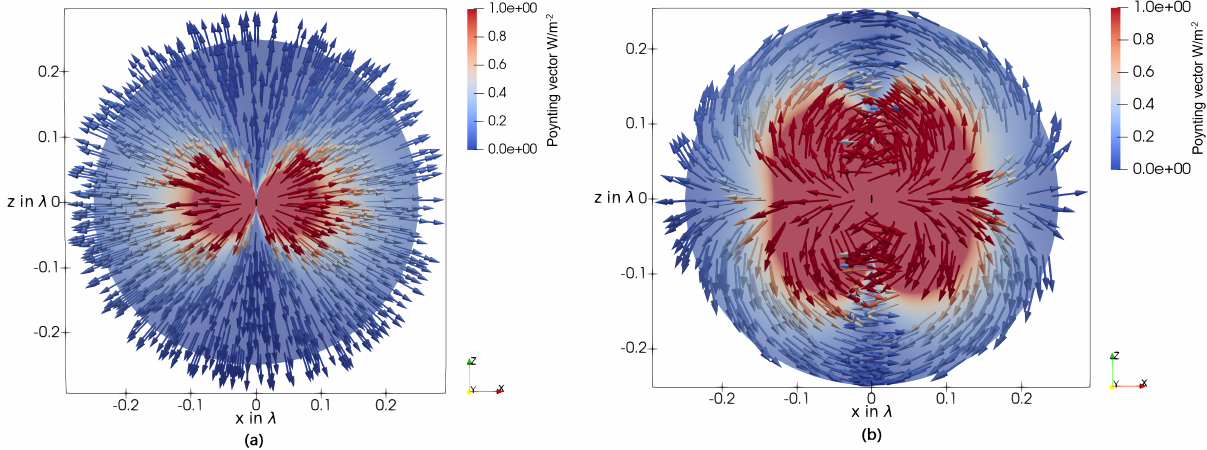
Figure 3. ( a ) Real part of the Poynting vector around an HD in the E-plane, respectively, in the x/z plane. ( b ) Imaginary part of the Poynting vector around an HD in the